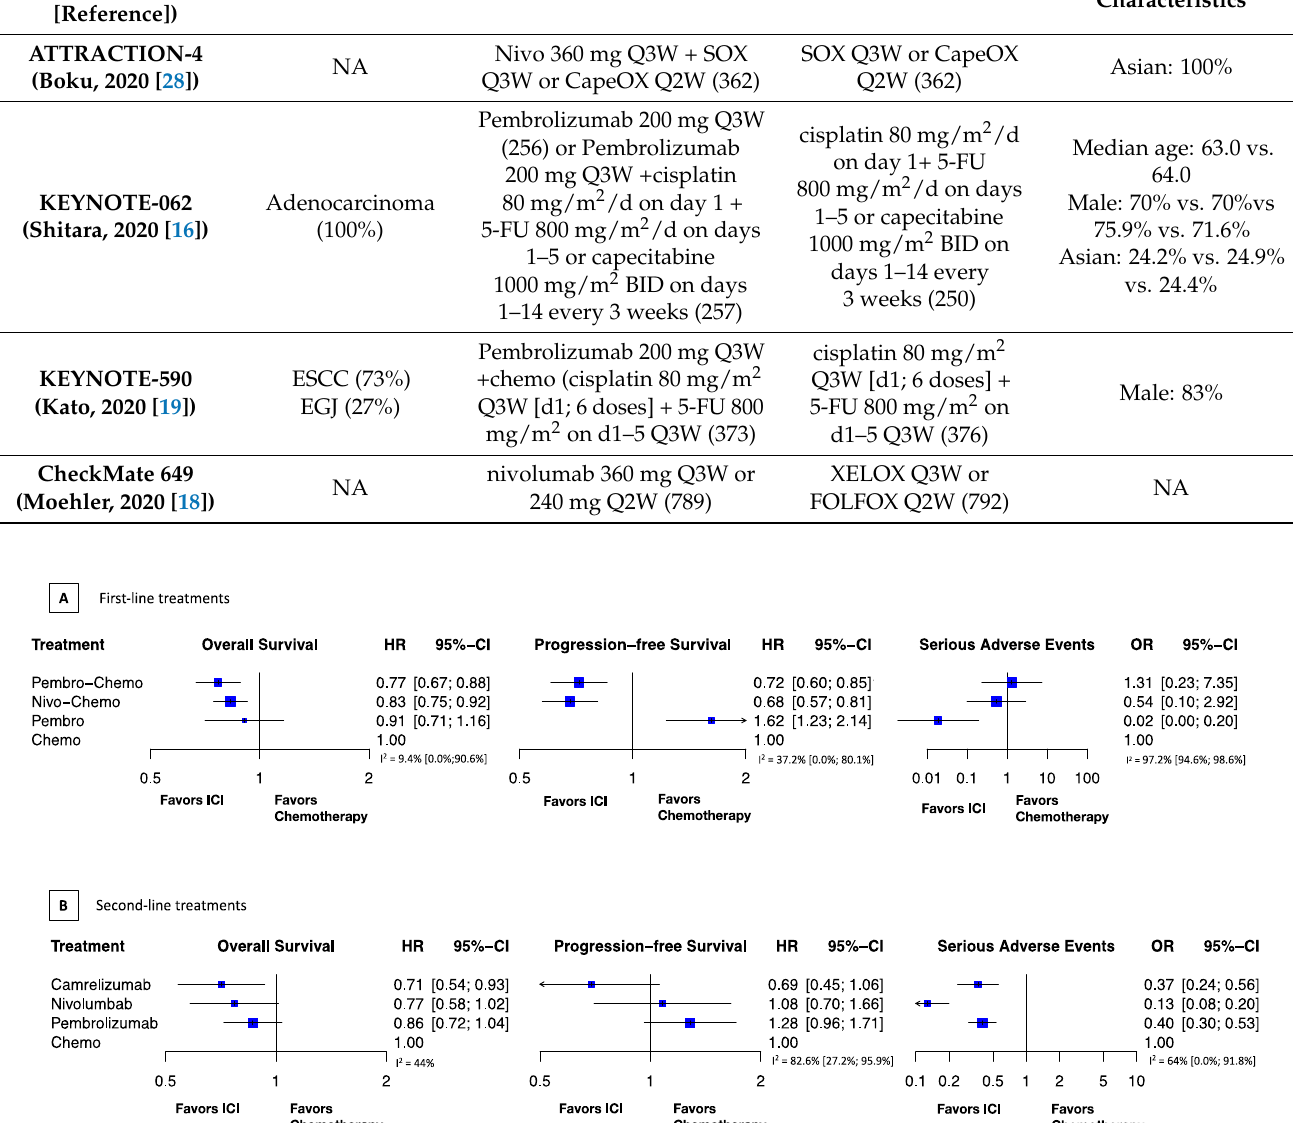
Table 2. Risk of bias assessment, first-line trials.